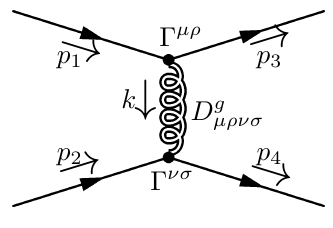
Figure 3 . The Feynman diagram for proton-proton scattering via tree-level glueball exchange in the t